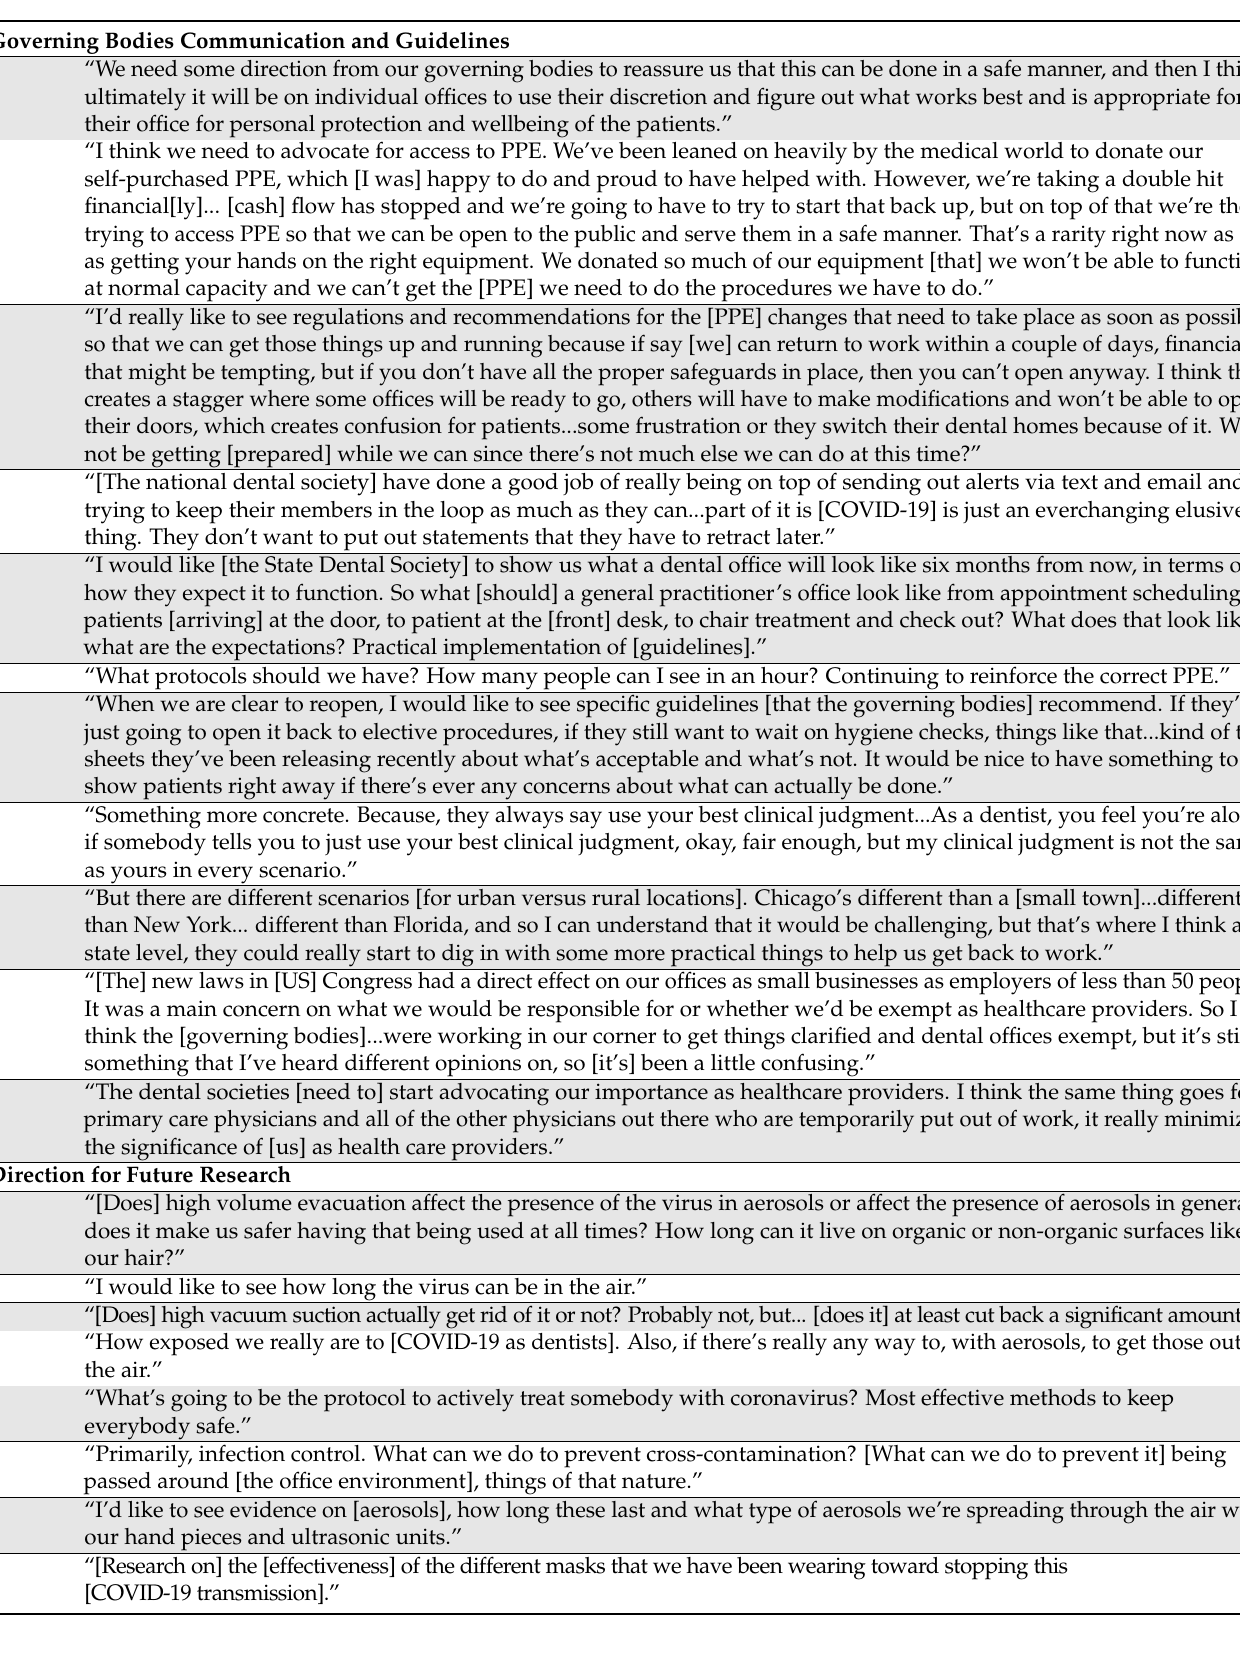
Table 4. COVID-19 Professional Communication and Dental